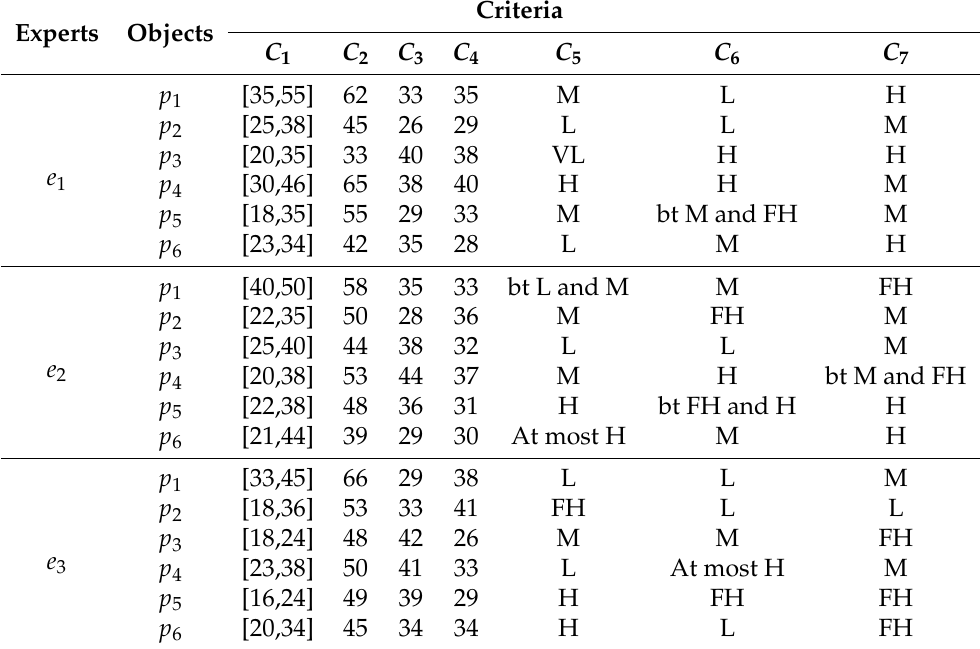
Table 4. Collected information of X h provided by